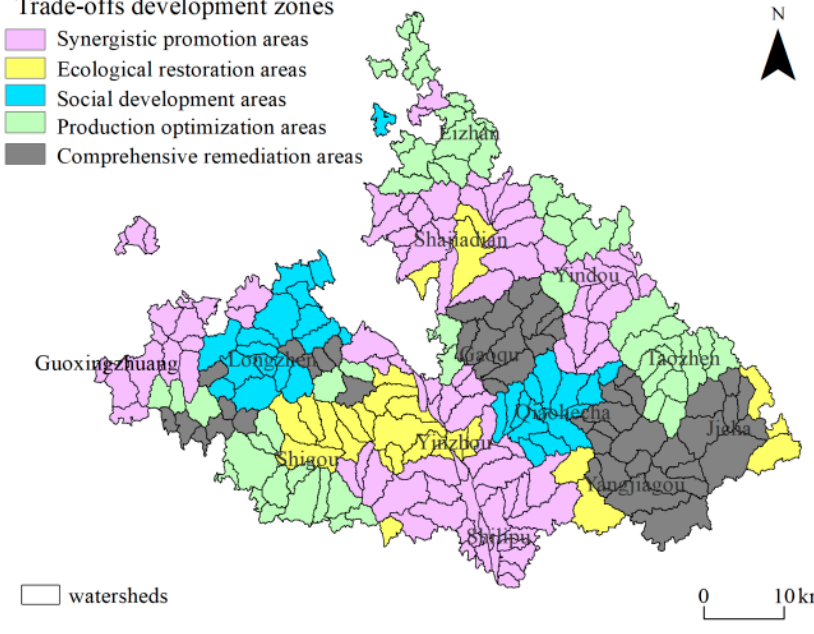
Figure 4. Integrated trade-off zoning at a watershed scale .